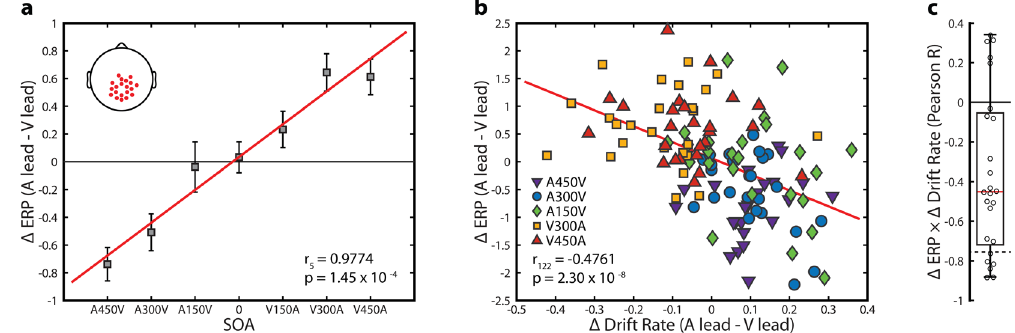
Figure 8. Relationship between neural activity and changes in drift rate. ( a ) Change in voltage between the auditory lead and visual lead conditions for each of the seven SOAs on the current trial. Data was pooled across the 20 electrodes and 200 time points (368–567 ms) found to be significant in all spatiotemporal clusters. Error bars indicate standard error of the mean. Inset: The 20 selected electrodes. Red line indicates the linear regression fit. ( b ) Relationship between change in drift rate and change in evoked amplitude pooled across the five SOAs which demonstrated significant drift rate modulation based on lead type. Values were pooled as in A. Red line indicates the linear regression fit. ( c ) Distribution of within subject correlations between change in drift rate and change in evoked potential amplitude. Each dot is one participant. The dashed line indicates the critical value (r < − 0.7545) for a significant within subject negative correlation (p < 0.05, two-tailed) between change in drift rate and change in